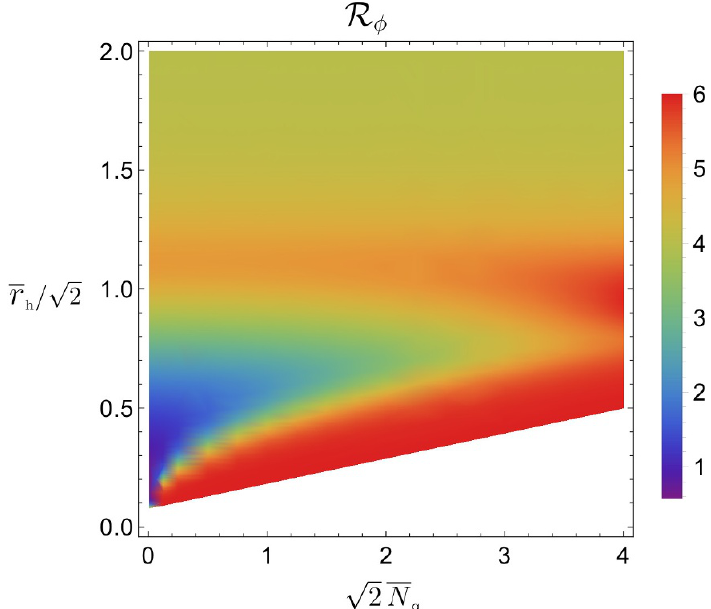
Figure 11 . Dilaton scaling